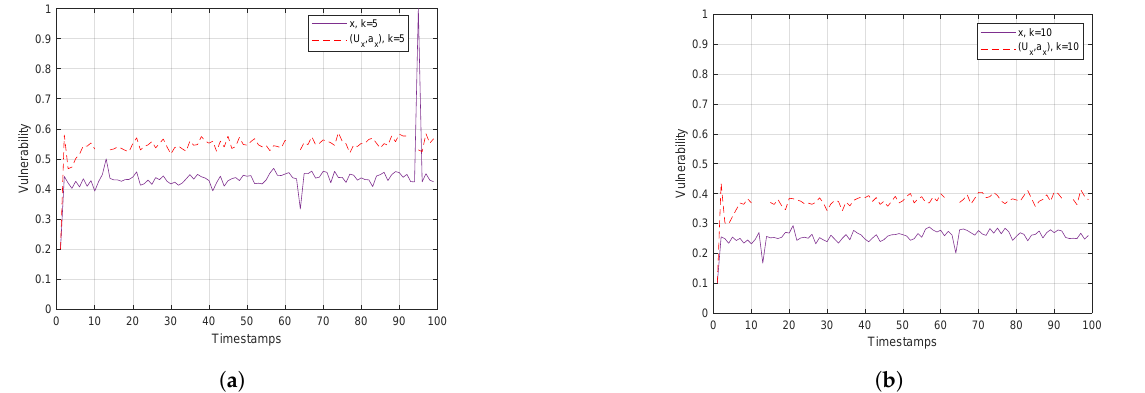
Figure 10. Hough- X Space of x for ( a ) k = 5 and ( b ) k = 10 for N = 500 Trajectories, L = 100 Timestamps.